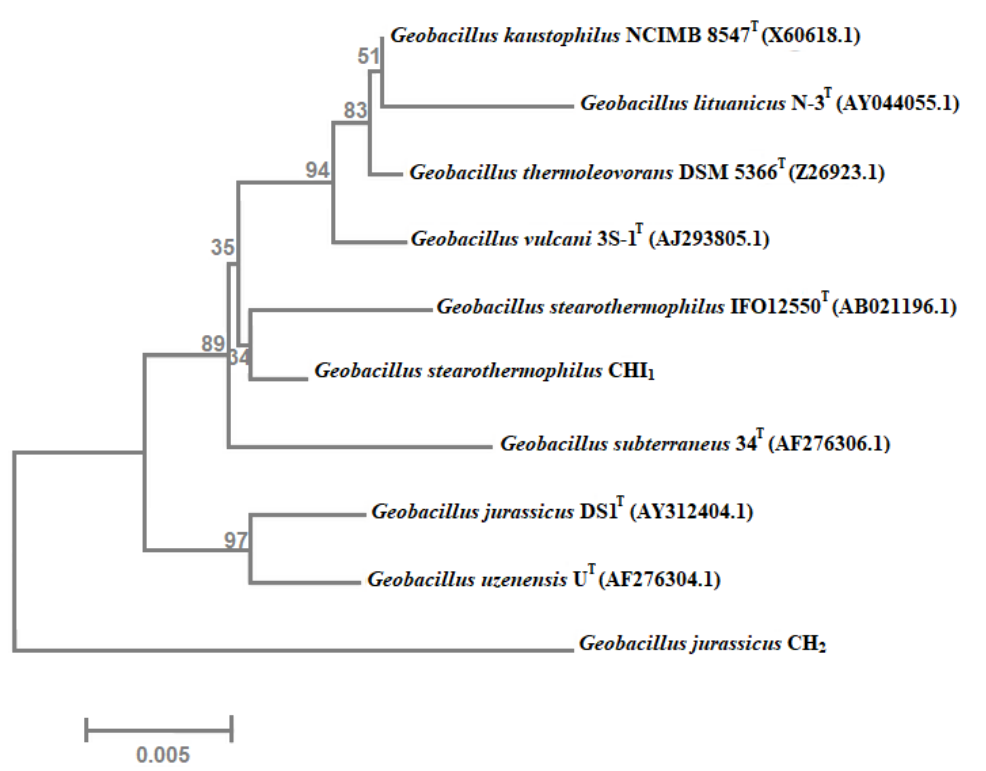
Figure 5. Phylogenetic tree on the basis of 16S rRNA data of the lipase-producing thermophilic bacteria ( G. jurassicus CHI 2 and G. stearothermophilus CHI 1 ) isolated from the crater lake of El Chichón volcano. Bootstrap values calculated for 1000 replications are indicated. Bar—0.5% substitutions in nucleotide sequence. Accession numbers are given in parentheses.